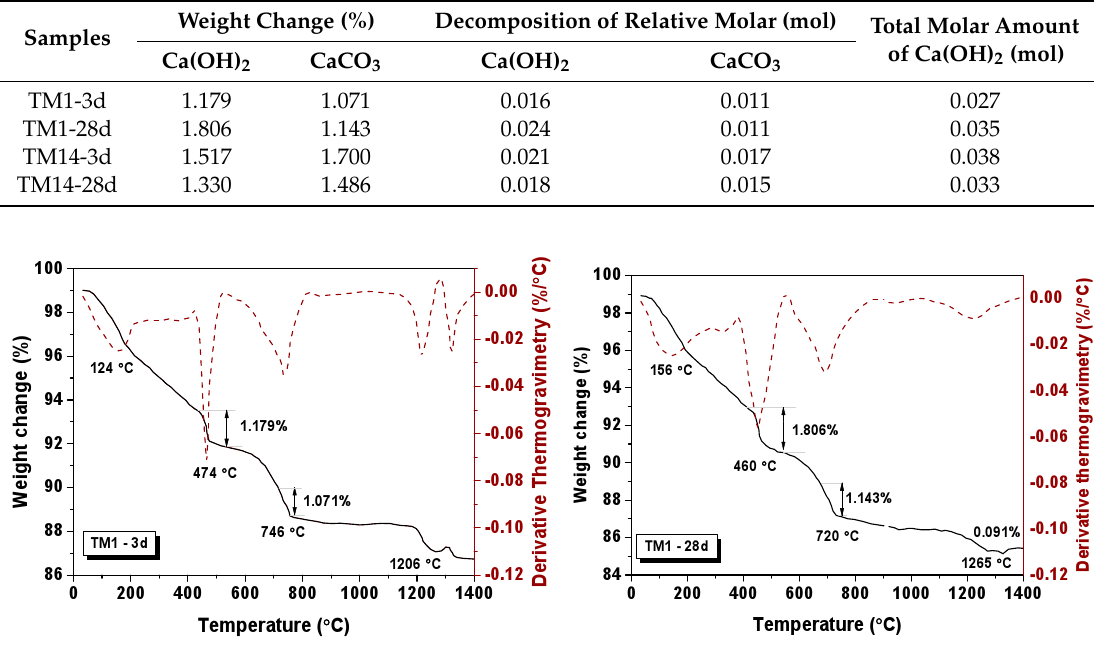
Figure 10. TGA-DTG spectra for TM1-3d and TM1-28d.